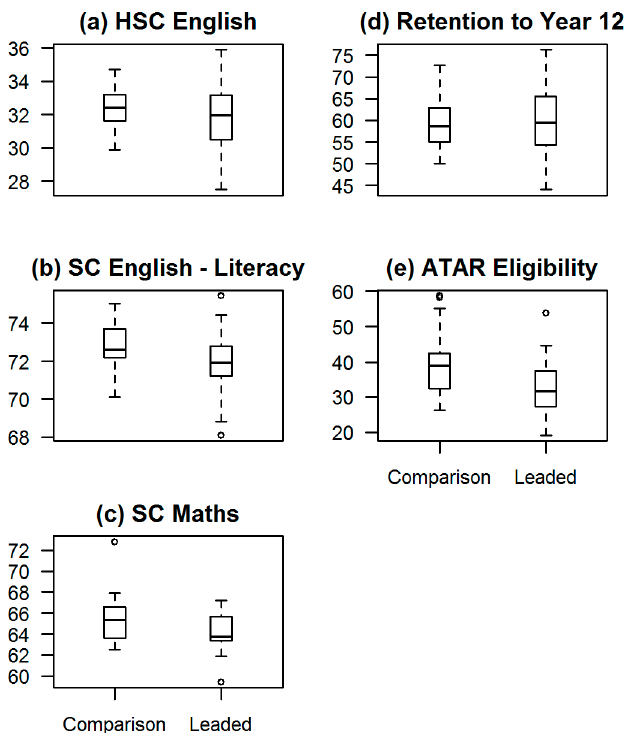
English-Literacy; ( c ) SC Mathematics; ( d ) Rate of retention to Year 12; ( e ) ATAR eligibility